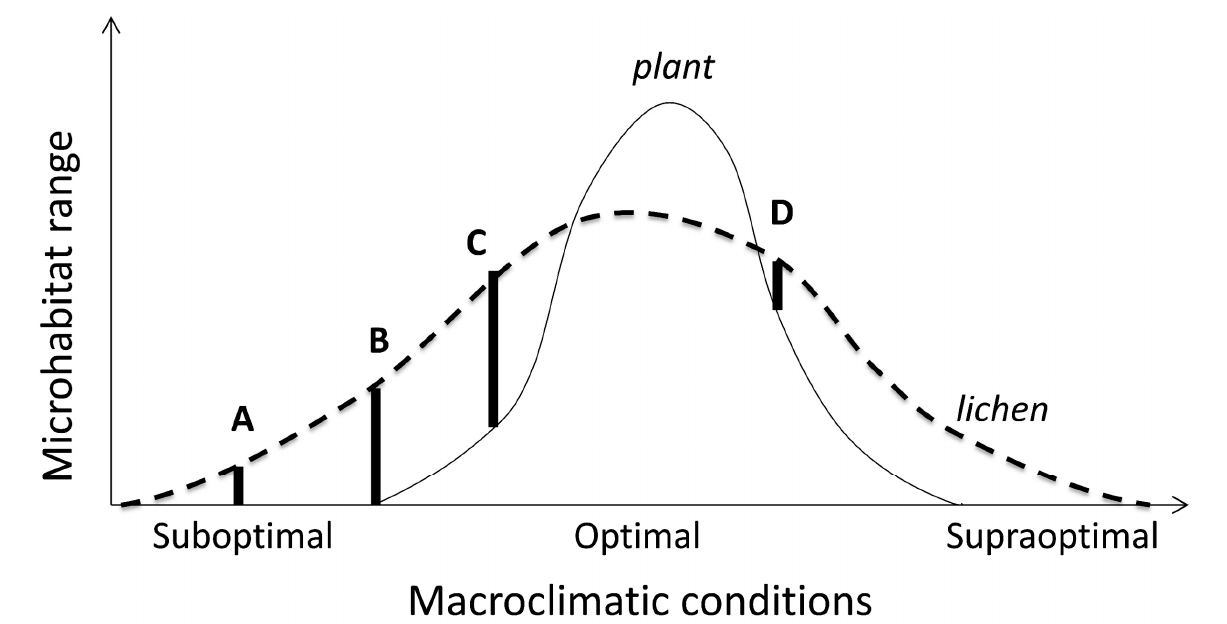
Figure 4. Conceptual model of microhabitat variation along a macroclimatic gradient in a stress tolerant organism (lichen). Its microhabitat range A is constrained abiotically compared to B (envi- ronmental filtering sensu [142]); while the range C reflects competitive release compared with D. In the optimal climate, it is excluded from all potential microhabitats by a superior competitor (plant). Note that A and D have similar microhabitat niche breadths but different positions (i.e., different microhabitat sets) and their limiting factors. The principle extends to various shapes of the curves provided their partial overlap and consistently asymmetric competition, and to macrohabitat scales where suitable microhabitats are present.